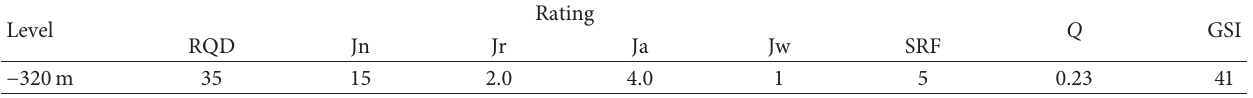
Table 3: Rock mass classification results by using Q-system and GSI-system in the drift.